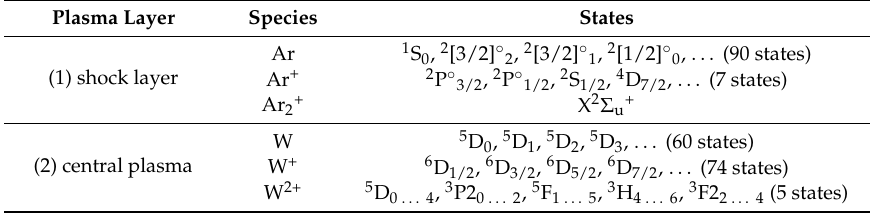
Table 3. List of the species and their excited states involved in the CR model CoRaM-Ar and CoRaM-W developed at the CORIA laboratory for the laser-induced plasmas on W in a rare gas (here for